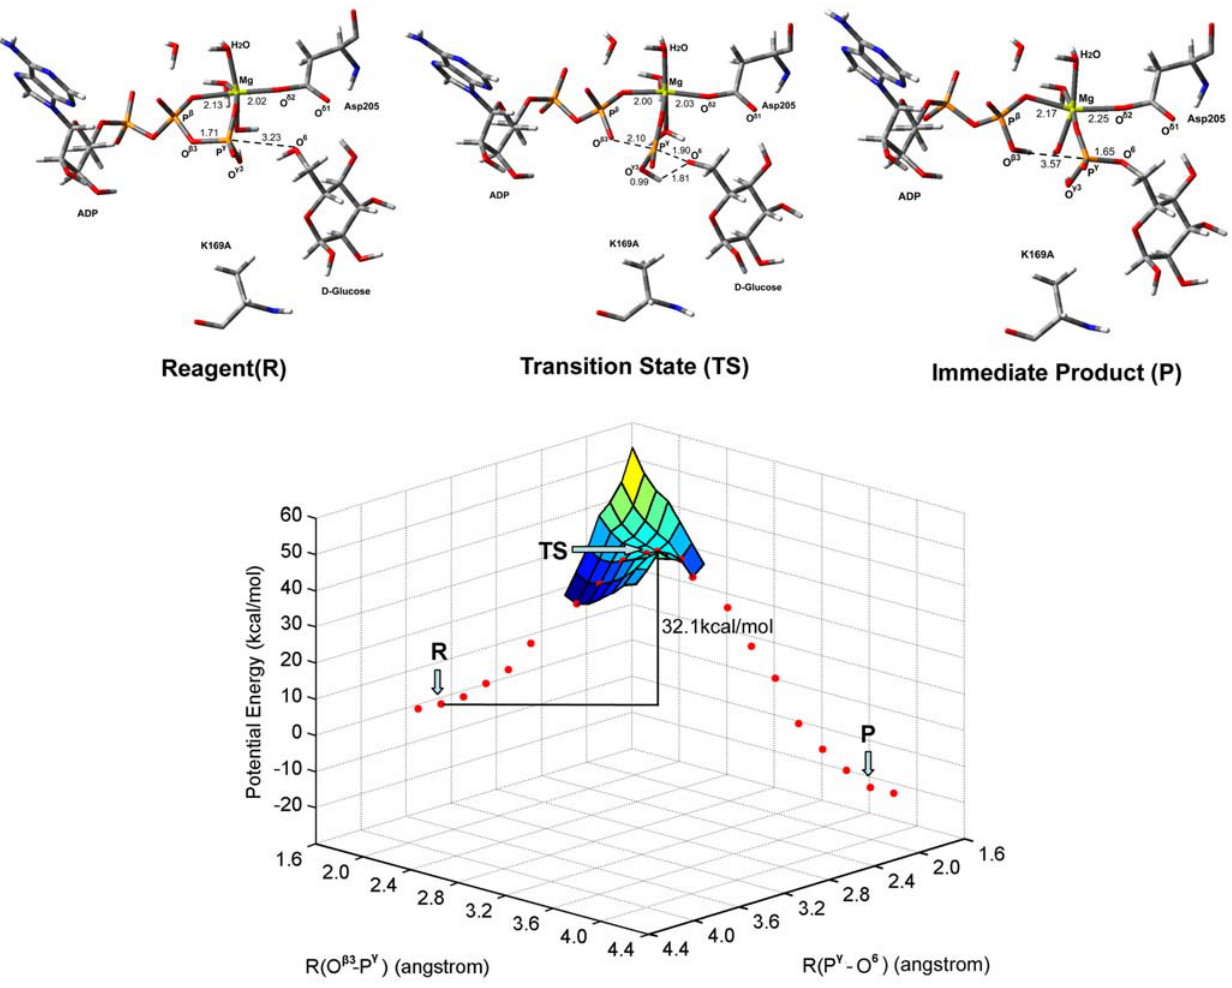
Figure 4. The potential energy surface of the reaction pathway corresponding to Scheme 2. The structures displayed at the top of the potential surface are the QM/MM optimized structures of the reagent (R), transition state (TS), and immediate product (P). For clarity, only the structures around the reaction center have been shown.